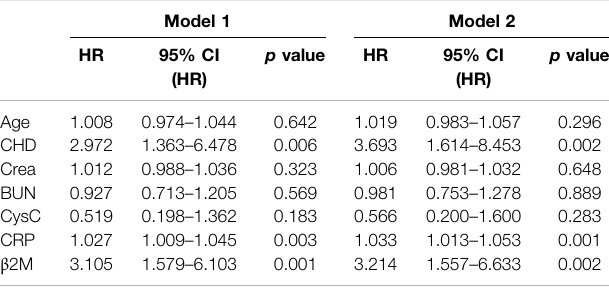
TABLE 4 | Predictive risk factors for recurrent AIS using Cox proportional hazard